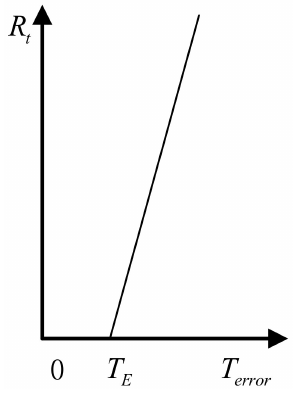
Figure 5. Punctuality penalty function.